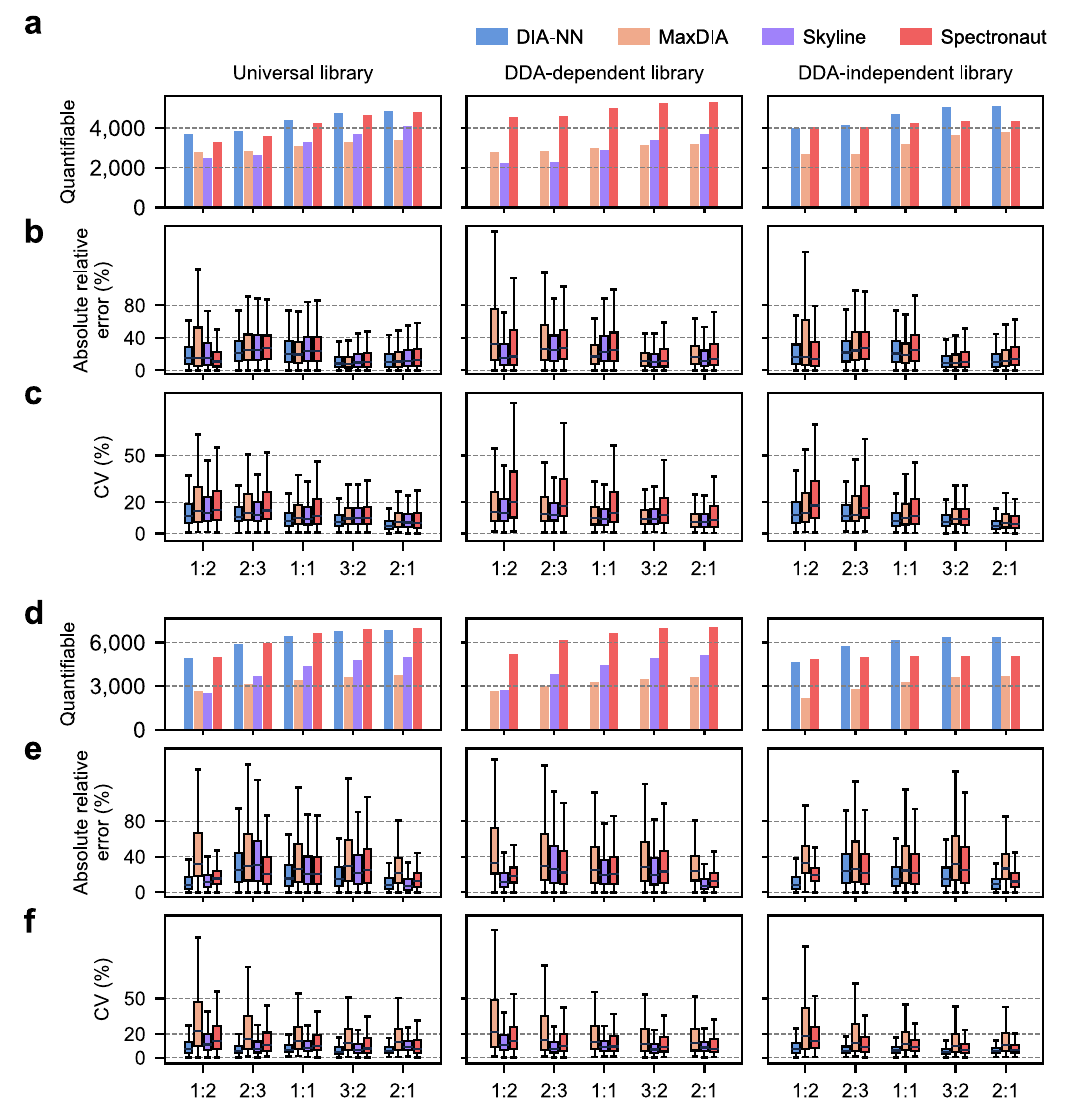
Fig. 3 | Evaluation of quanti fi cation performance. a Number of quanti fi able mouse proteins (quanti fi ed in at least three of fi ve replicates) yielded by different analysiswork fl owsundereachconditionwiththeexpectedproteinratiofrom1:2to 2:1 for HF data. Results are summarized for each software equipped with a speci fi c library as de fi ned in Fig. 1b. b Distribution of absolute relative errors between expected and measured protein ratios by different analysis work fl ows under each